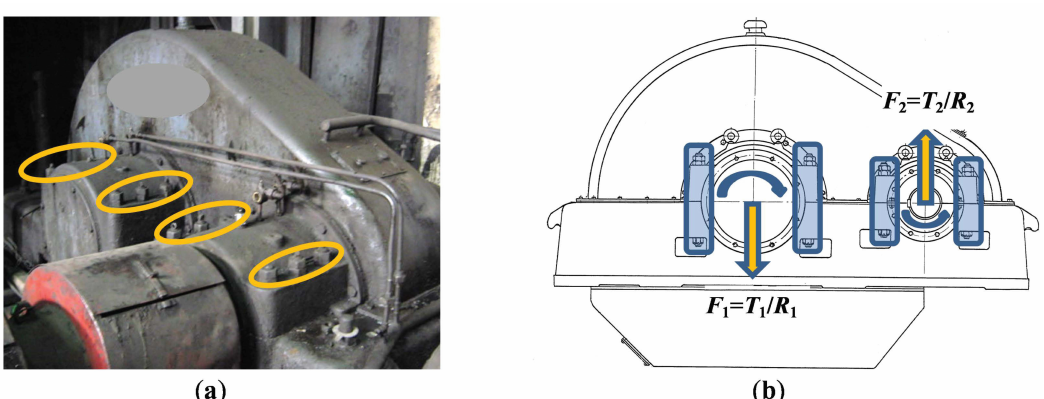
Figure 5. Industrial heavy-duty gearbox with bolt studs joints ( a ); scale drawing of bearing supports with applied torques and forces provoking shafts transient motions ( b ).